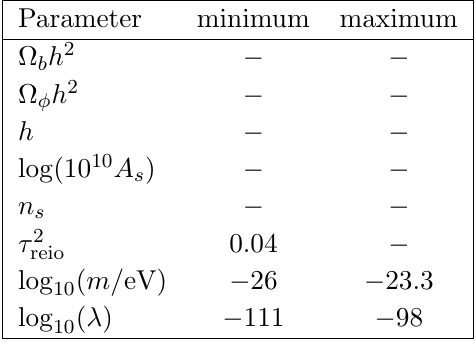
Table 1 . Prior ranges on the base (cid:3)CDM parameters and the model parameters m and (cid:21) . A symbol means that there is no prior. Additionally, the (cid:12)xed parameters include the neutrino (cid:0) properties. In our case, two massless neutrinos plus a massive one with m = 0 : 06 eV, such that N e(cid:11) = 3 : 046 and m (cid:23) = (cid:10) (cid:23) = 93 : 14